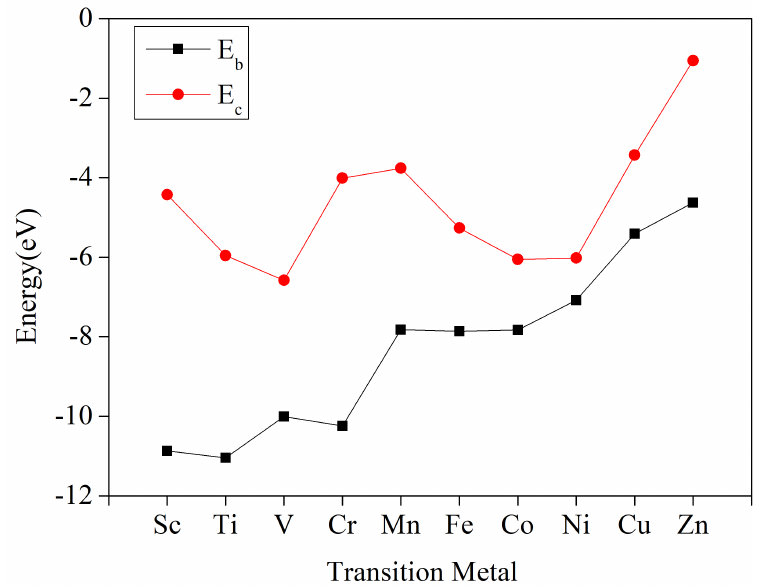
Figure 3. E c is the cohesion energy of the bulk metal, E b is the binding energy between the transition metal atoms and the tetrahydroxybenzoquinone